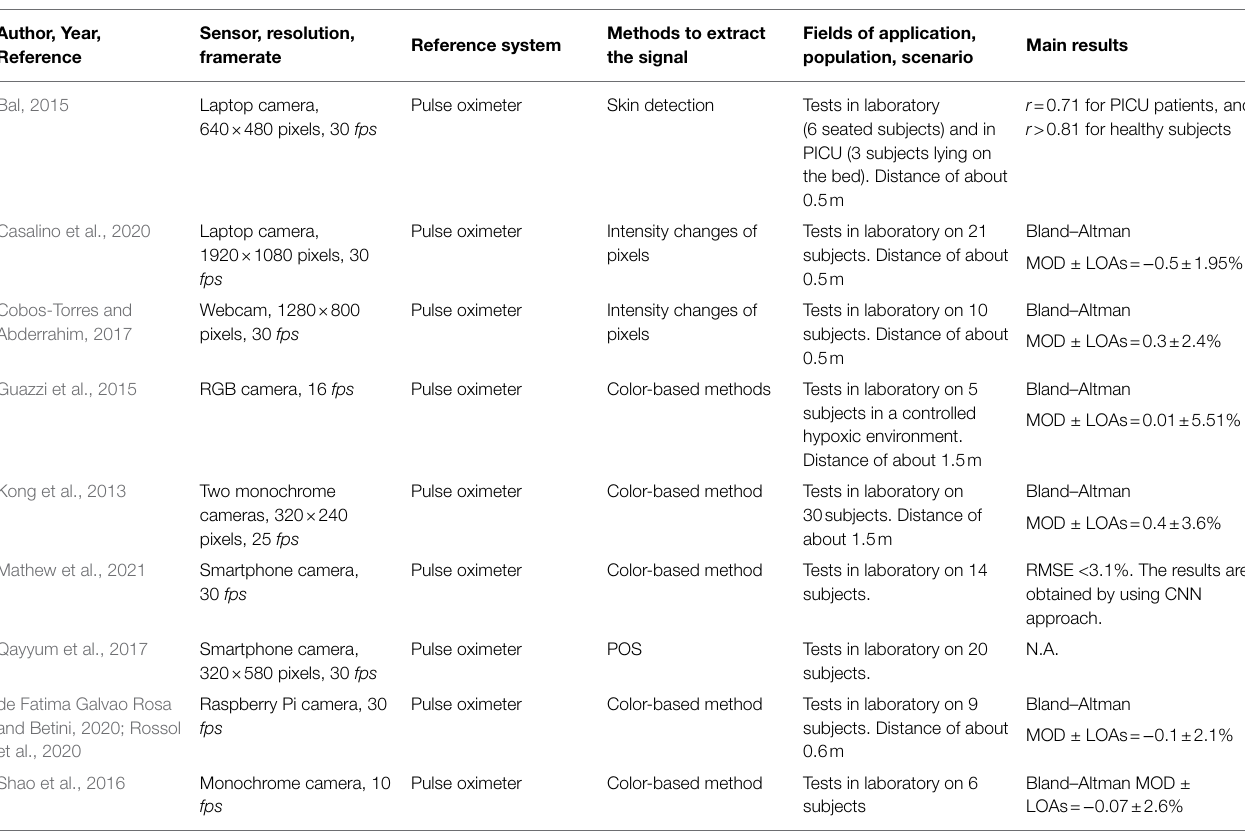
TABLE 3 | Studies using digital cameras for estimating SpO 2 in different fields of